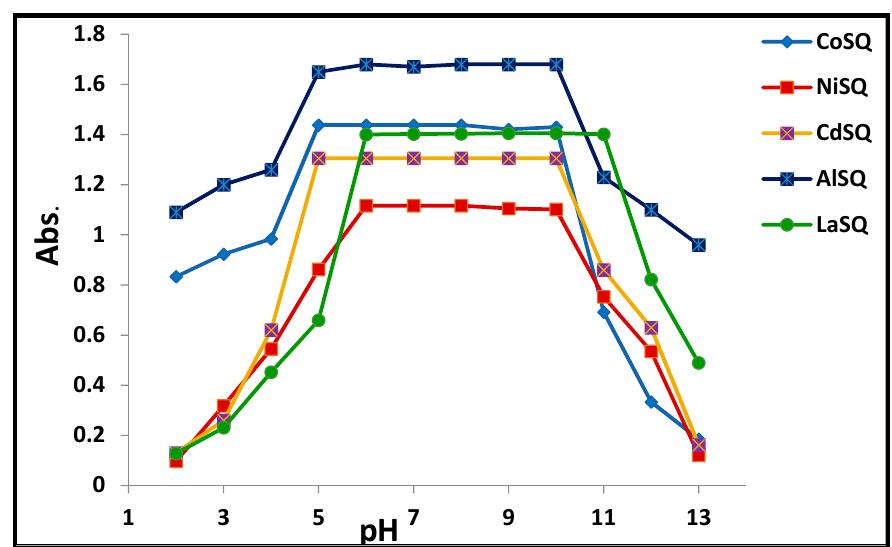
Figure 4. Dissociation curve of the mixed ligand metal complexes in DMSO.